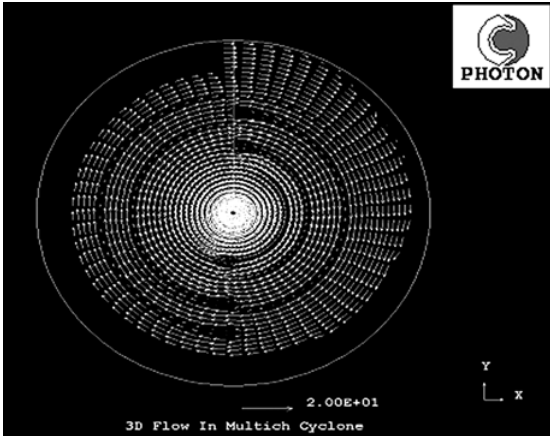
Fig. 3. Mid-plane z velocity vectors: inlet velocity 5.1 m/s.; the scale of velocity vectors – 20.0 m/s, from the top of the separation chamber of cyclone is z = 0.05 m